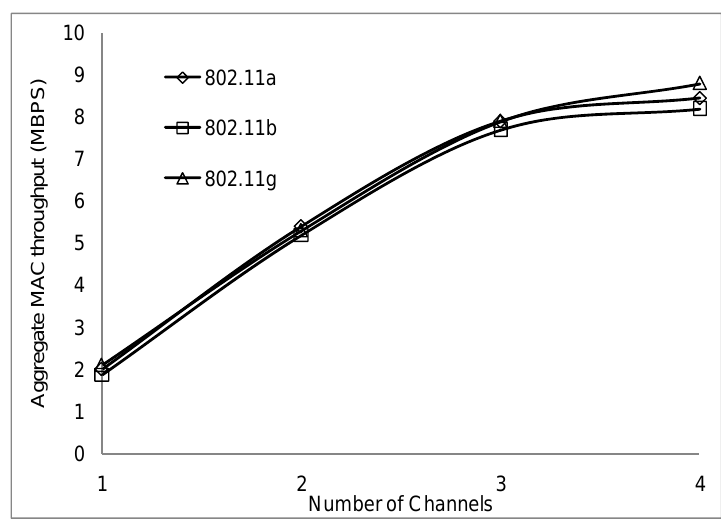
Figure 26. Aggregate throughput at 50 m range and data rate of 10 Mbps.